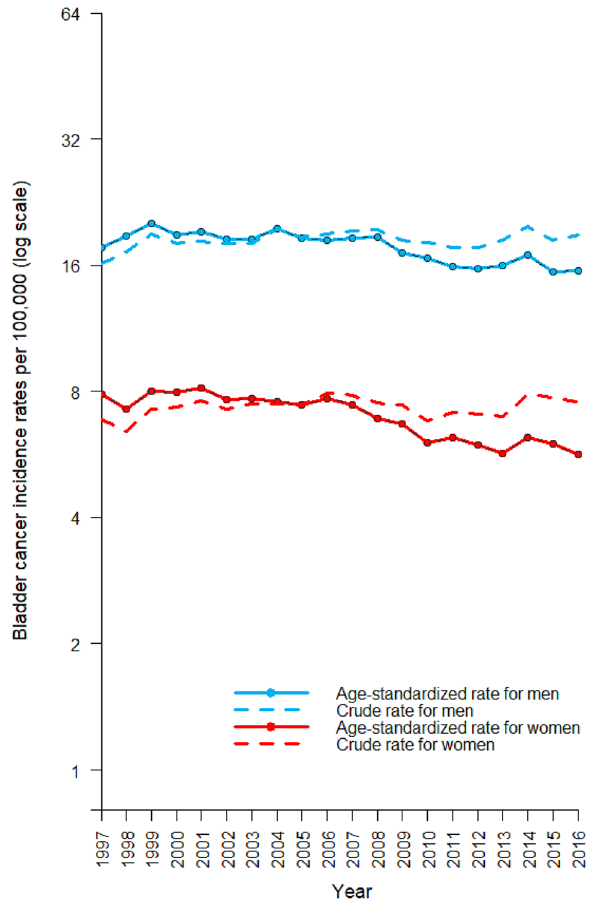
Figure 1. The crude and age-standardized incidence rates of bladder cancer for men (blue) and women (red). The WHO’s 2000 World Standard Populations were used to compute the truncated age-standardized incidence rate (age range 25–85